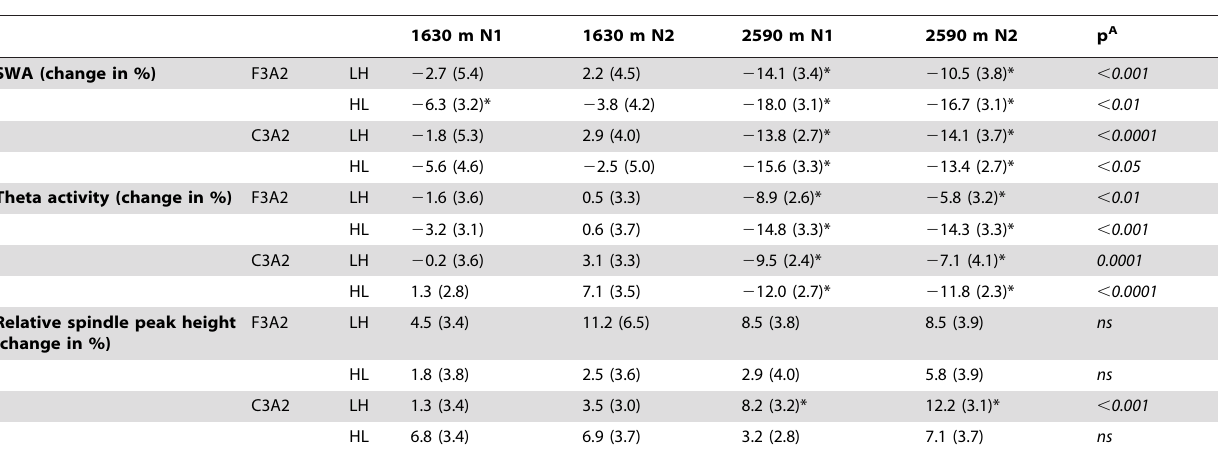
Table 2. Changes in spectral variables at moderate